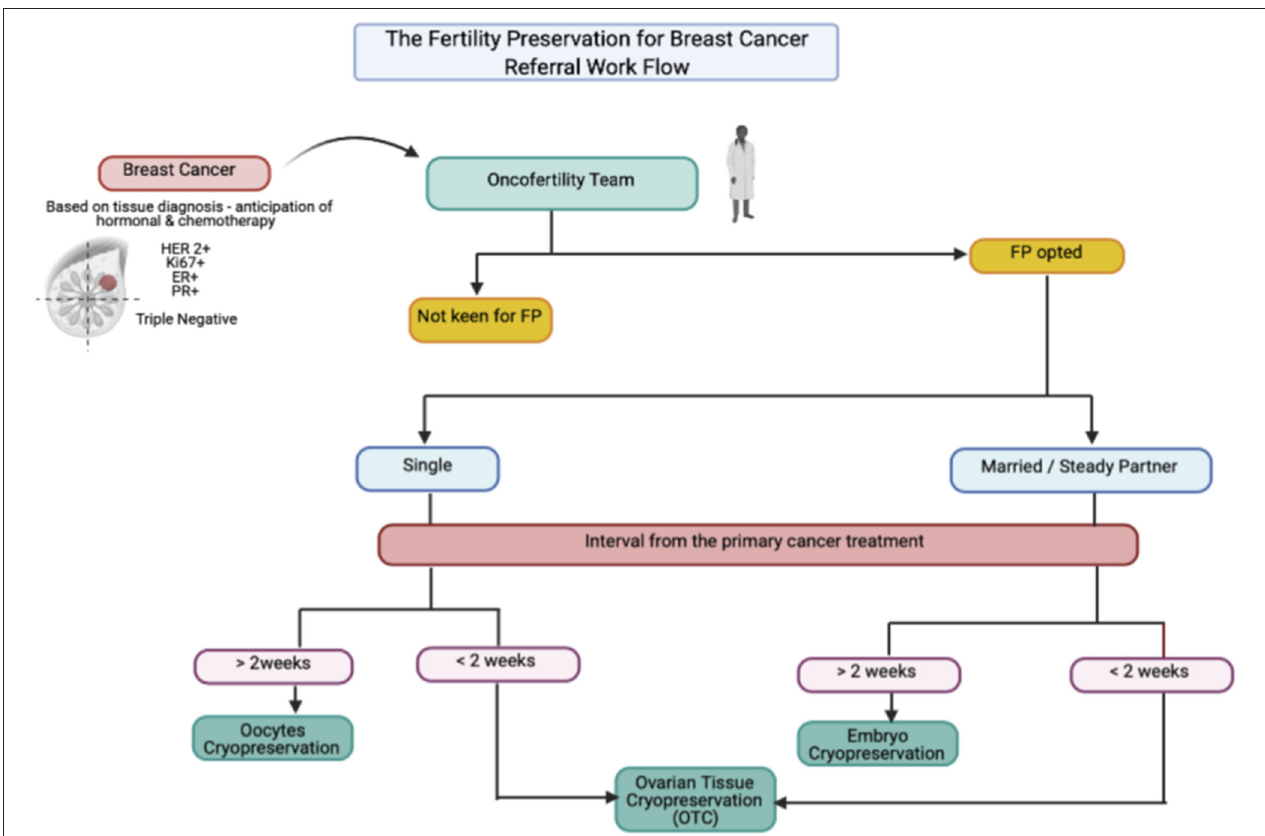
FIGURE 1 | The suggested referral work flow for oncofertility referral for breast cancer cases.